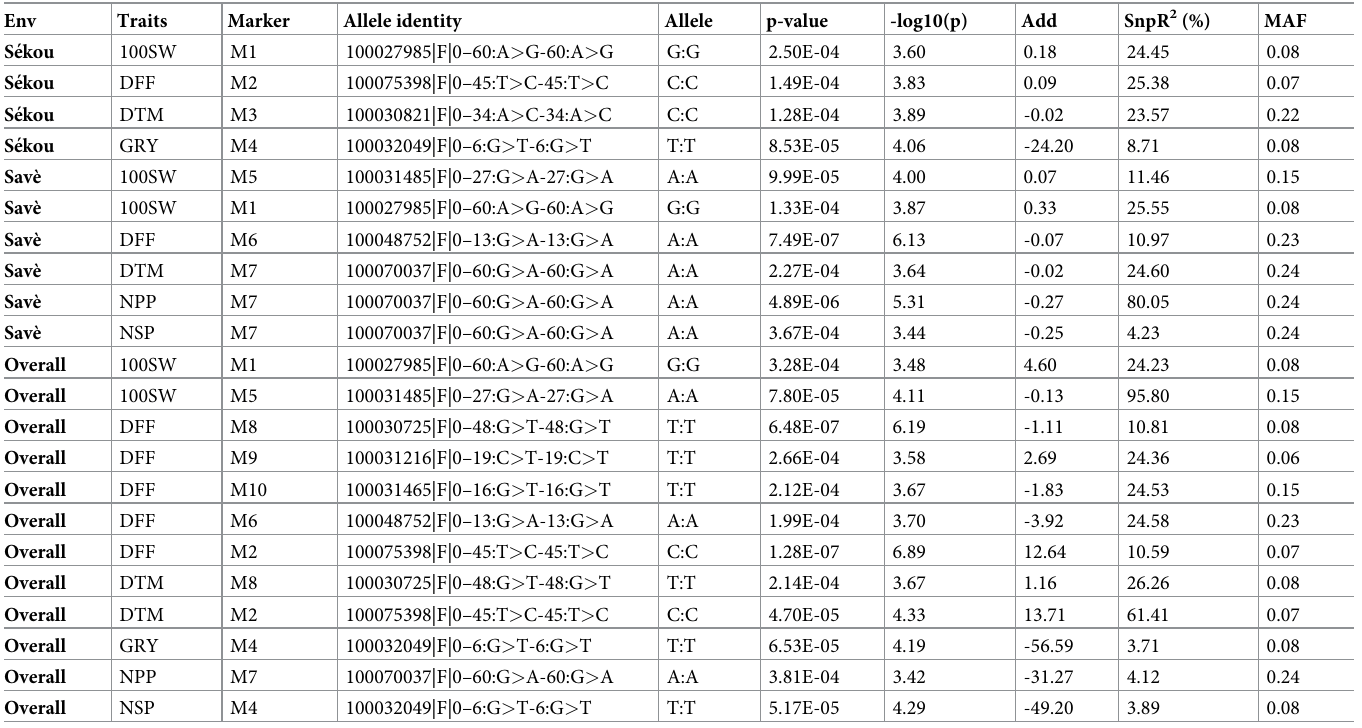
Table 10. GWAS results within and across environments for grain yield and related traits. Env Traits